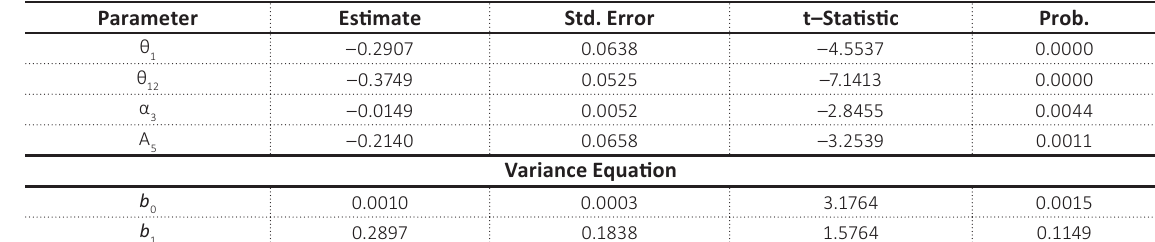
Table A5. Estimation results for (5-6) final model